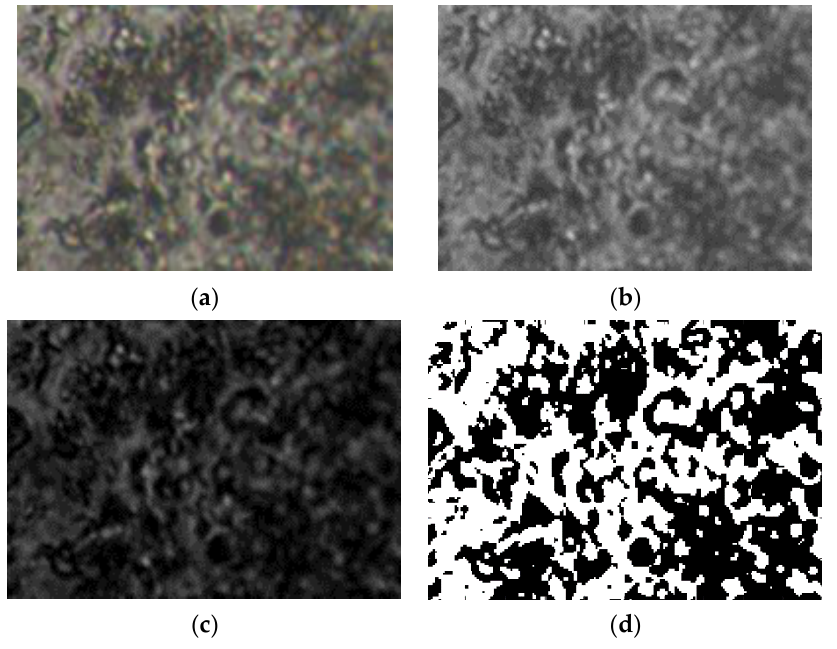
Figure 11. Primary processing of the selected image U 2 . ( a ) — original image (the entire portion); ( b ) — the grayscale version; ( c ) — the gray scale version without luminance; ( d ) — binarized version. A threshold of 25 was used for binarization. Table 2. Calculation of fractal parameters for picture U 2.